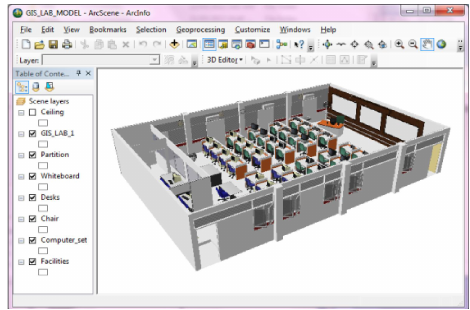
Figure 10. 3D Model with colour and texture